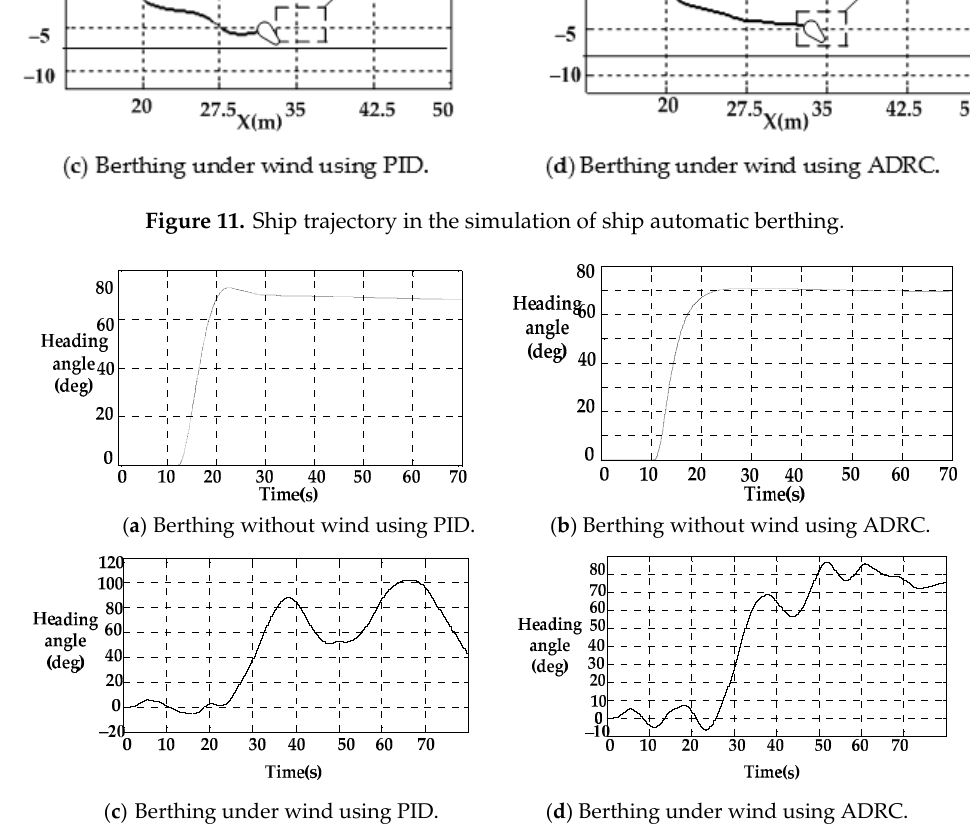
Figure 12 . Ship heading angle in the simulation of ship automatic berthing.